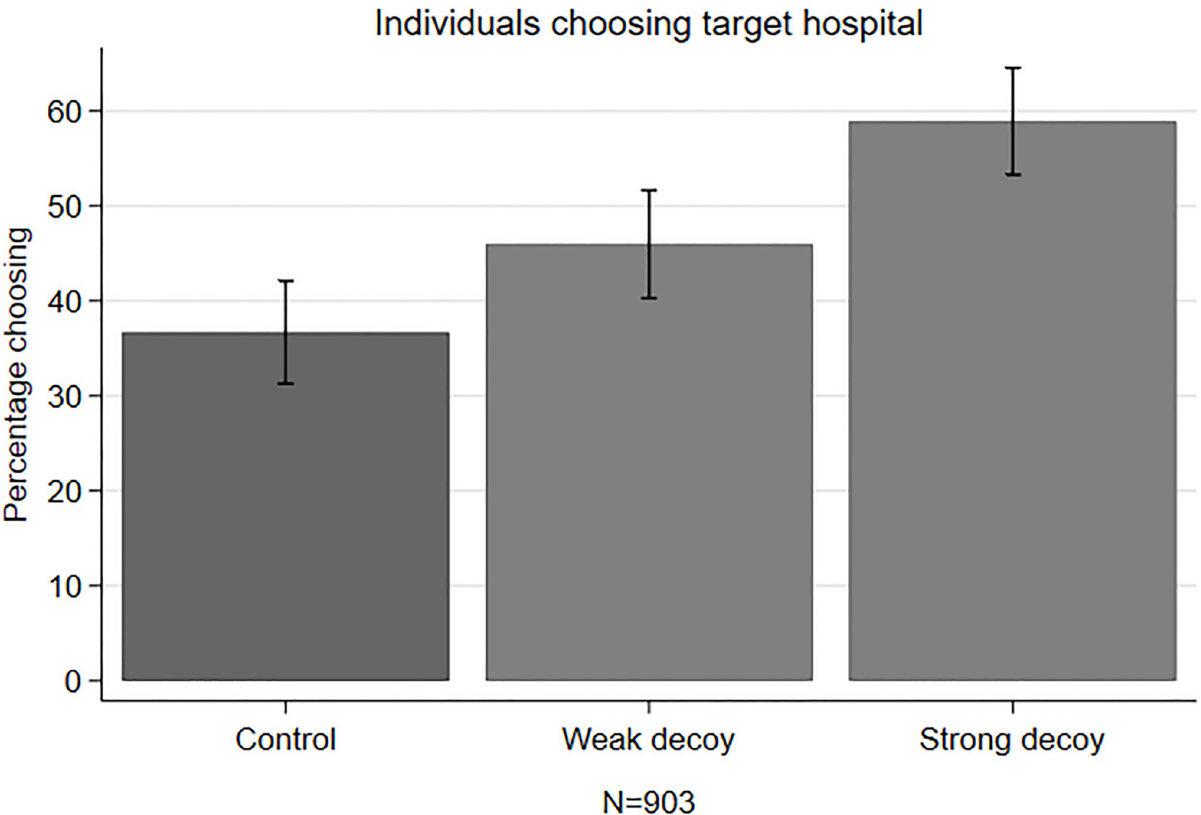
Fig 6. Mean percentage of choosing the target hospital.